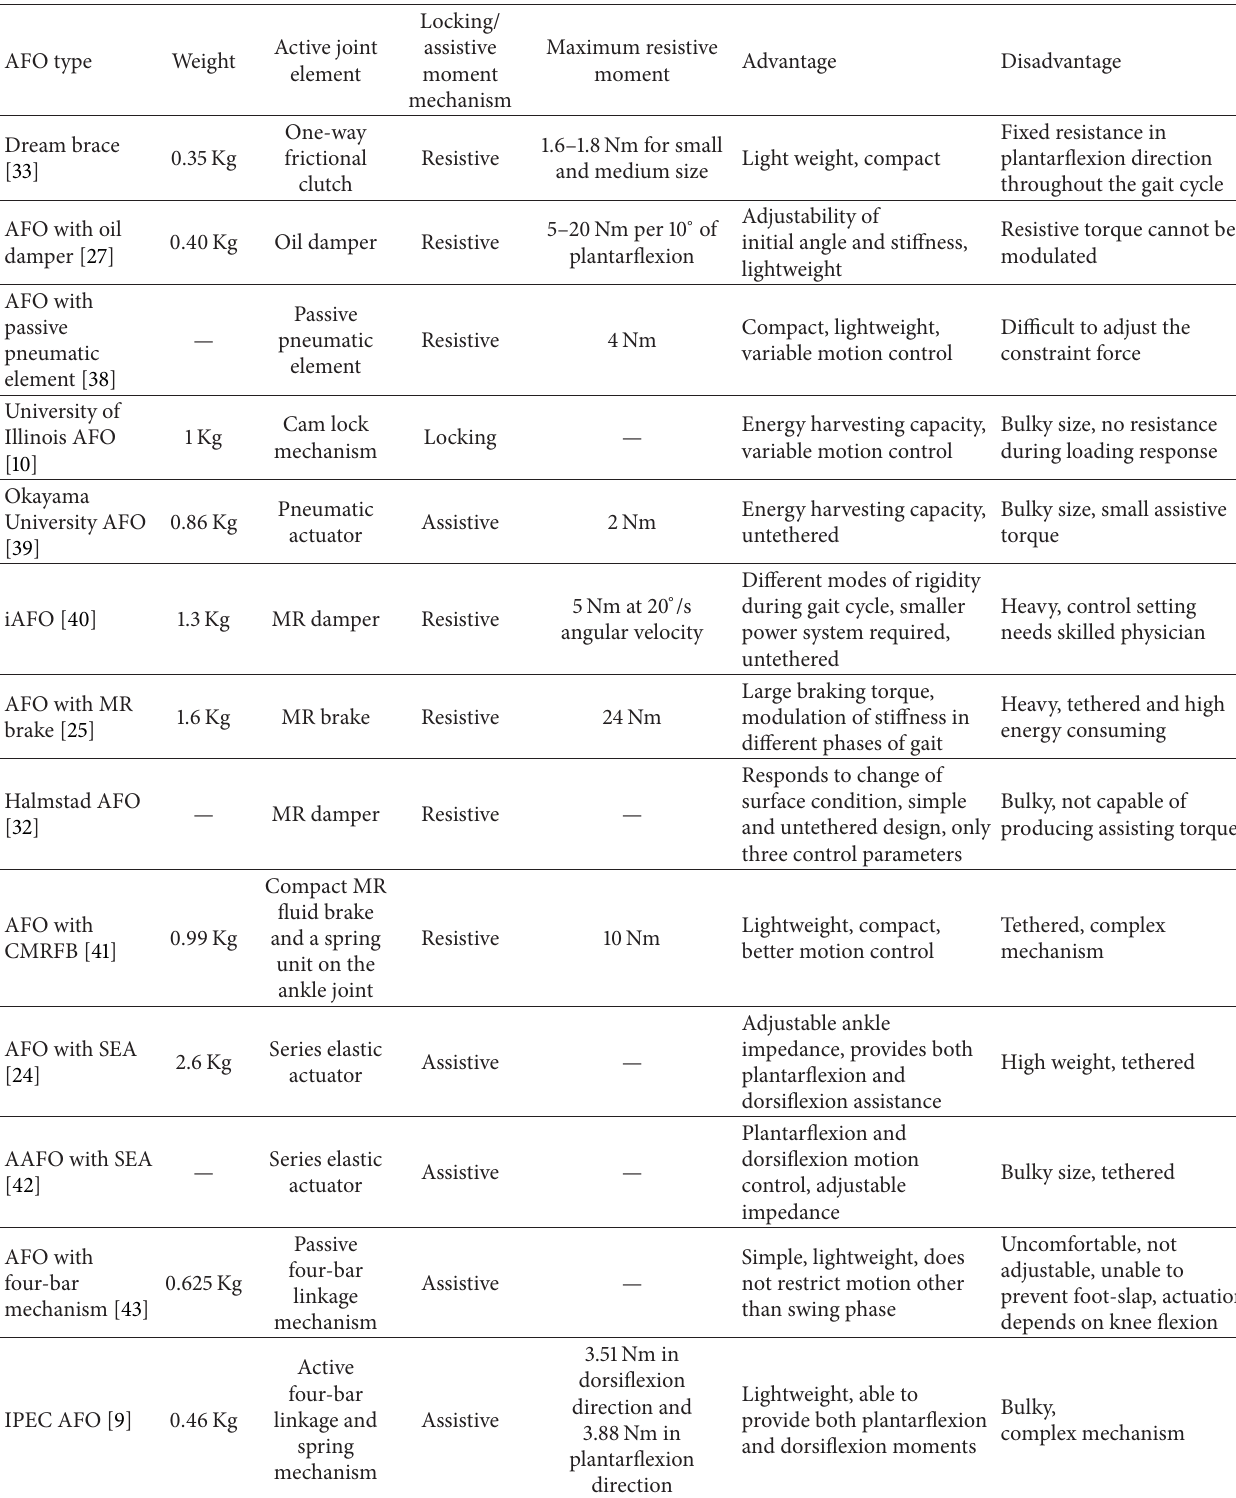
Table 1: Summary of reviewed